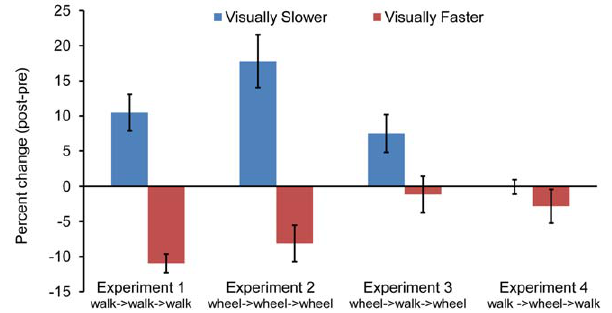
Figure 2. Percent change in distance walked (Experiments 1 and 4) and wheeled (Experiments 2 and 3).